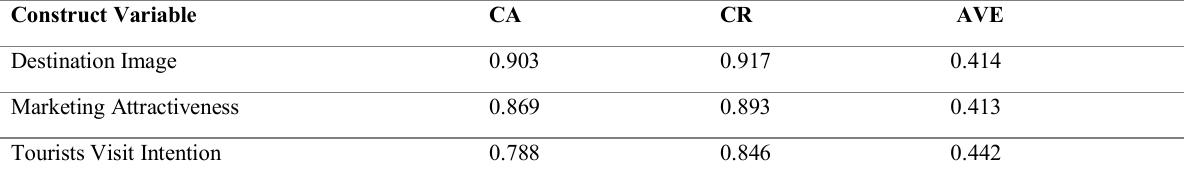
Table 4: Cronbach’s alpha, composite reliability and AVE value